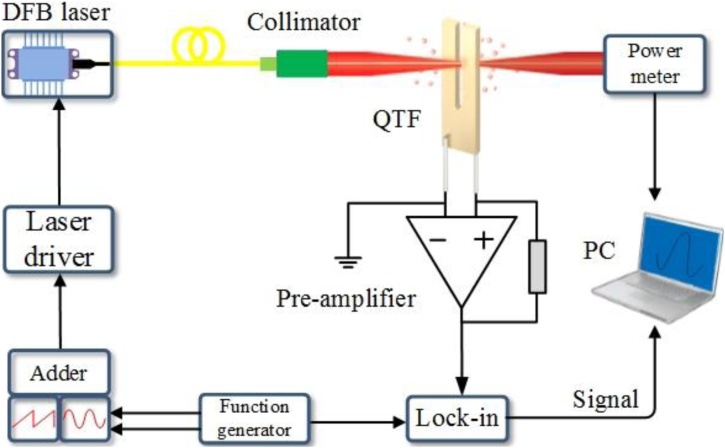
Schematic diagram of the QEPAS experimental setup. The double channel function generator produces a ramp signal with a frequency of 10 mHz and a sine signal with the frequency of 14 kHz to tune and modulate the DFB laser, respectively. PM: power meter, PC: personal computer.